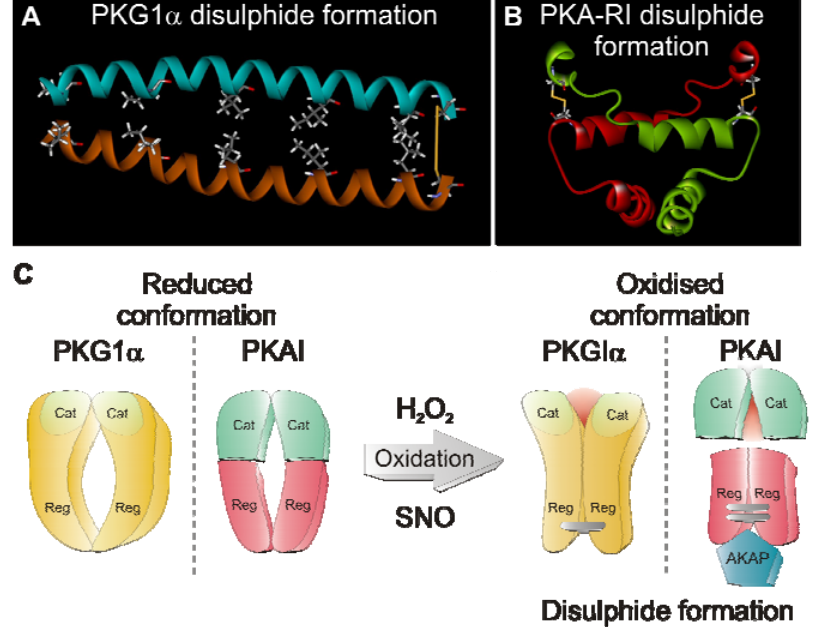
Figure 5. (a) The NMR structure of the N-terminal dimerisation domain of PKG1  including the redox sensitive disulphide bond (b) The NMR structure of the dimerisation domain of the type I alpha regulatory subunit of protein kinase A including the redox sensitive disulphides (c) The basic mechanism of how oxidants (H species of NO (SNO)) can augment PKG1  activity and enhance the affinity of PKAI for it binding partners, the